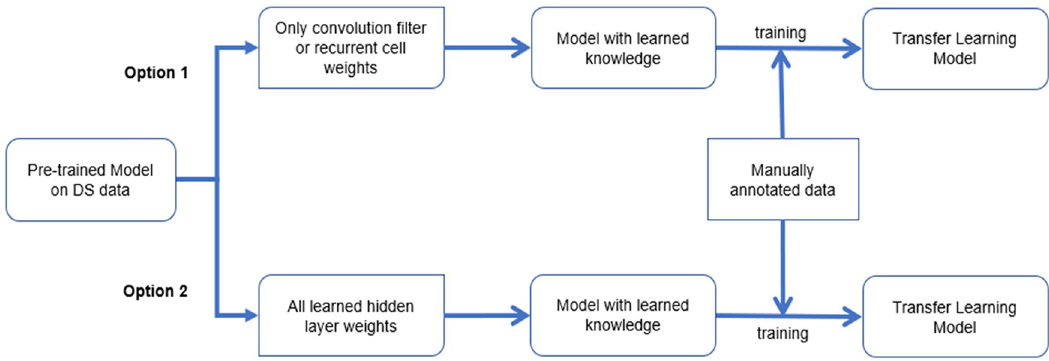
Fig 3. Pipeline of transfer learning model on both DS data and human-labeled